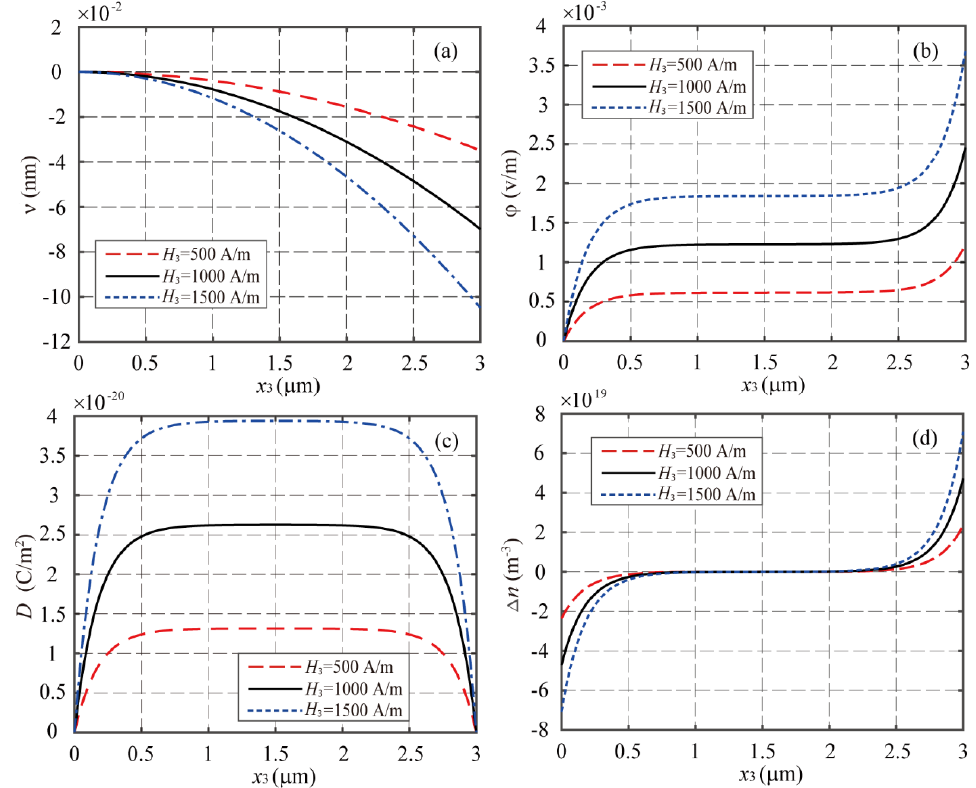
ϕ , ( c ) D , and ( d ) Δ n along the LMPS cantilever beam with